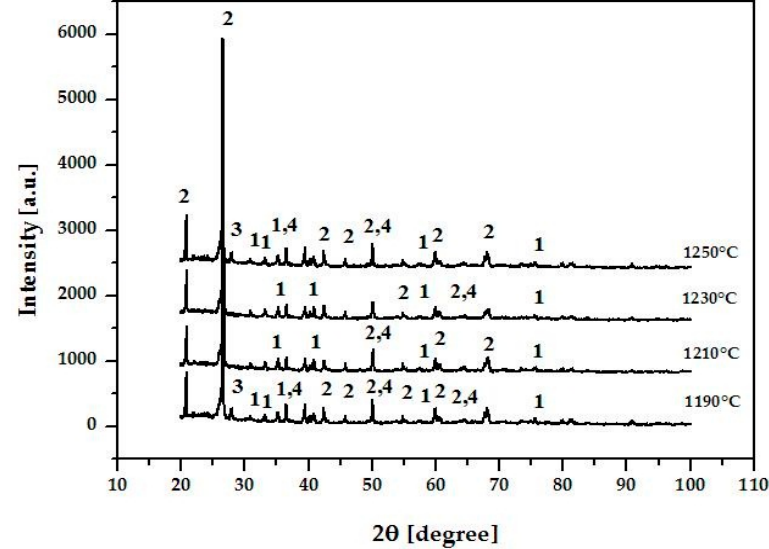
Figure 2. X-ray diffraction patterns of the ML3 formulation fired at various temperatures (1—mullite; 2—quartz; 3—albite; 4—hematite).